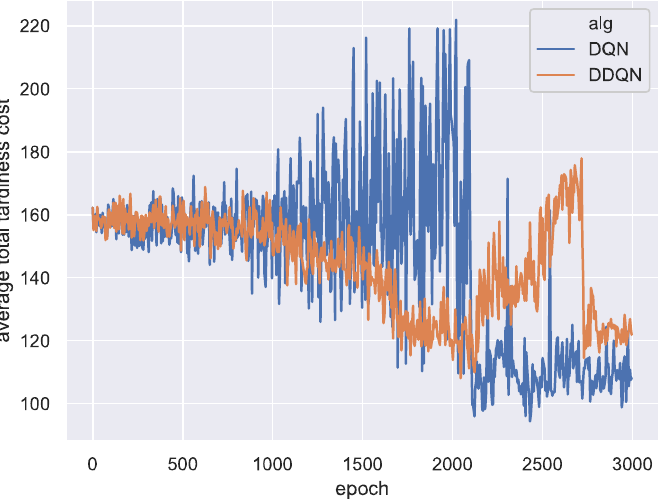
Figure 5. Average episode cost on all test instances at each training epoch for DQN and DDQN.